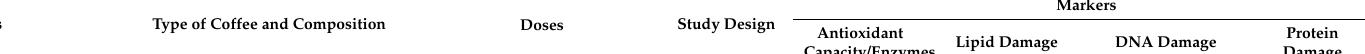
Markers Protein Antioxidant Capacity/Enzymes Lipid Damage DNA Damage